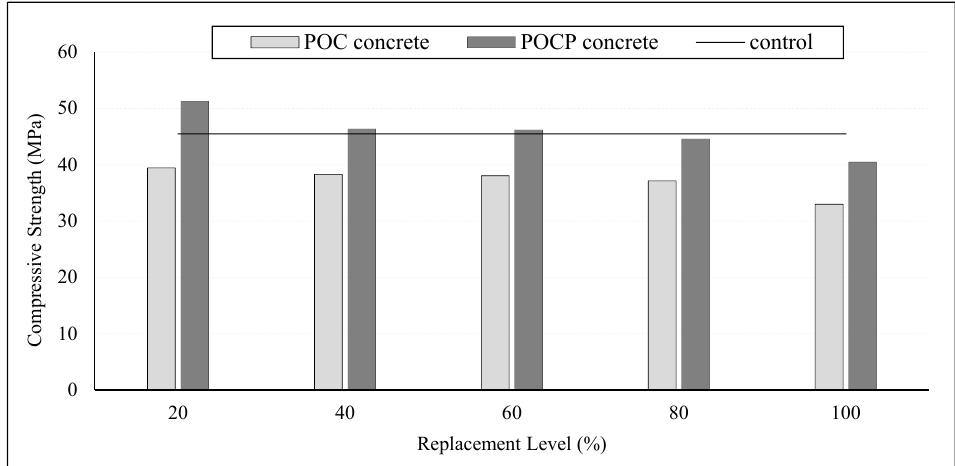
Figure 11. Difference in porosity of concrete. ( a ) Granite; ( b ) POC.